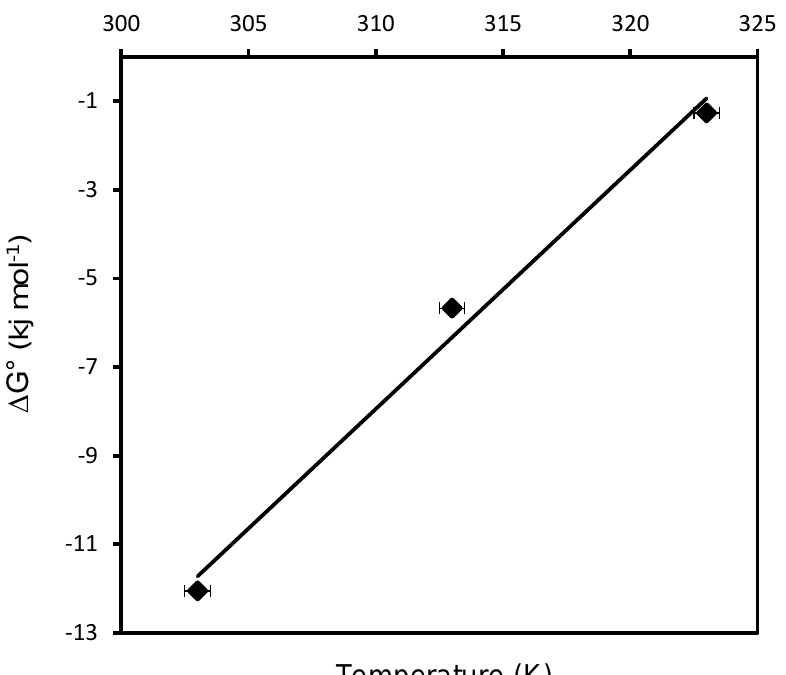
Figure 5. Thermodynamic plot of CR adsorption onto the Cu-ZnBO-Cp-CT. (Experimental conditions: Adsorbent dose = 2.5 g L −1 ; Contact time = 135 min; Agitation speed = 200 rpm; Solution pH = 7; CR Concentration = 10 mg L −1 ; Temperature = 30 °C).